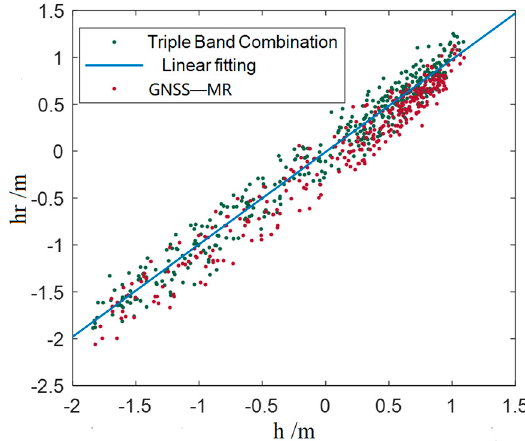
Figure 9. The relationship between the height of the GNSS-MR tide level inversion method/triple- frequency combined method and the tide level height of the tide gauge station.